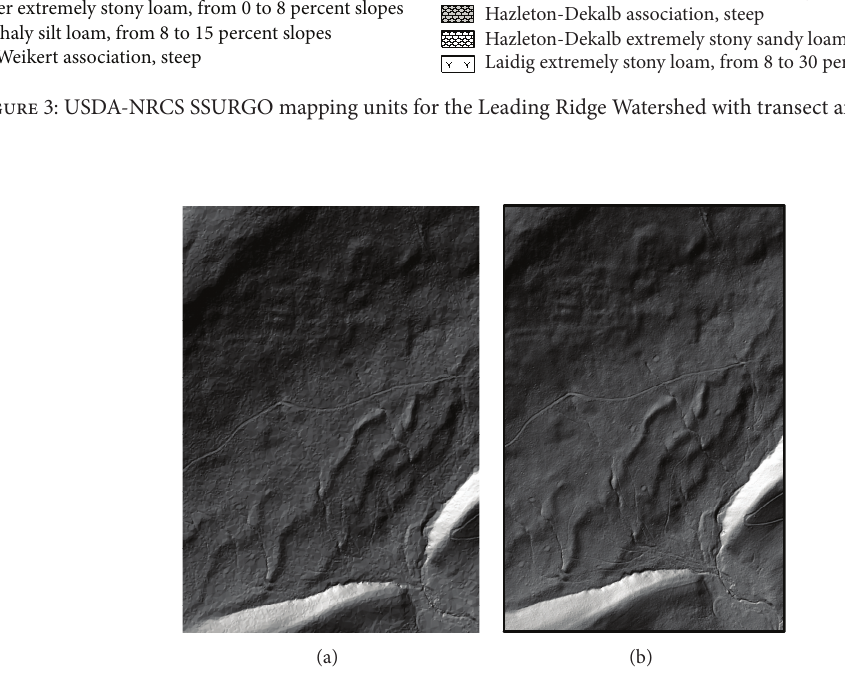
Figure 4: Shaded relief maps generated from PAMAP LiDAR (a) and CZO LiDAR (b). The TIN-based algorithm was used for the PAMAP LiDAR and is visible in the shaded relief map. Small trails and streams are clearly more visible in the CZO LiDAR